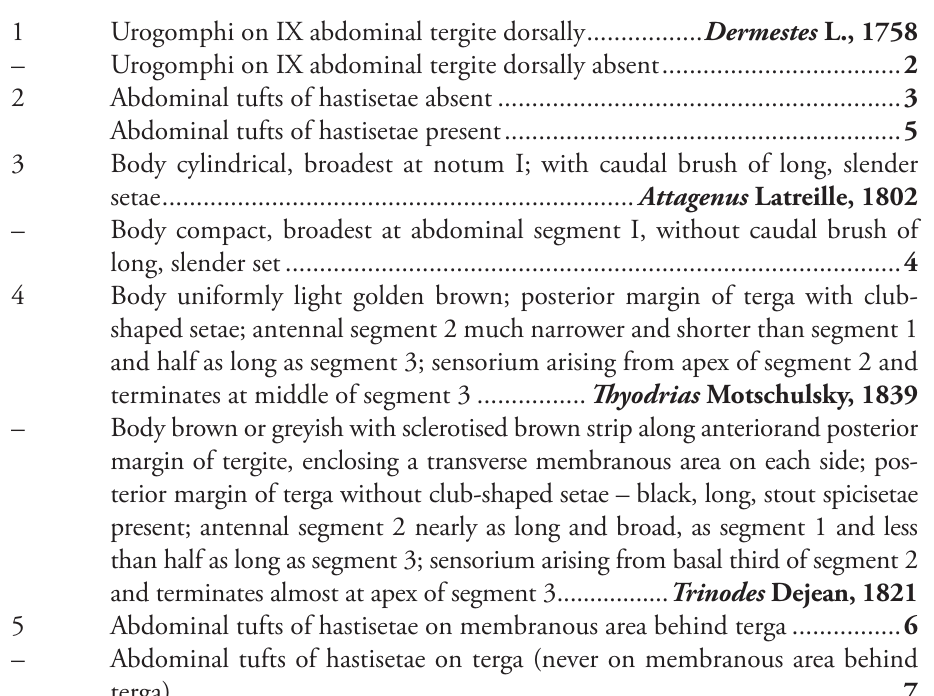
Body brown or greyish with sclerotised brown strip along anteriorand posterior margin of tergite, enclosing a transverse membranous area on each side; pos- terior margin of terga without club-shaped setae – black, long, stout spicisetae present; antennal segment 2 nearly as long and broad, as segment 1 and less than half as long as segment 3; sensorium arising from basal third of segment